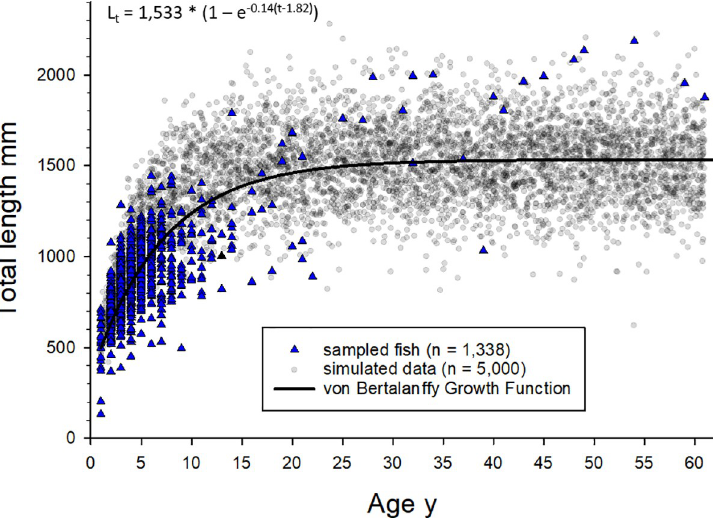
Fig 6. Von Bertalanffy growth function fit to observed and simulated Warsaw grouper length-age data. Von Bertalanffy growth function fit to observed (blue triangles; n = 1,338) and simulated (gray circles; n = 5,000) nGOM Warsaw grouper length-age data utilizing the Bayesian model described by Taylor et al. [34]; model priors and estimated parameters are listed in Table 1.